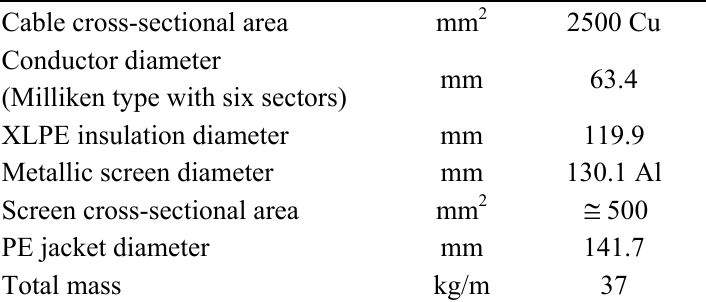
Table 1. EHV AC Cable under